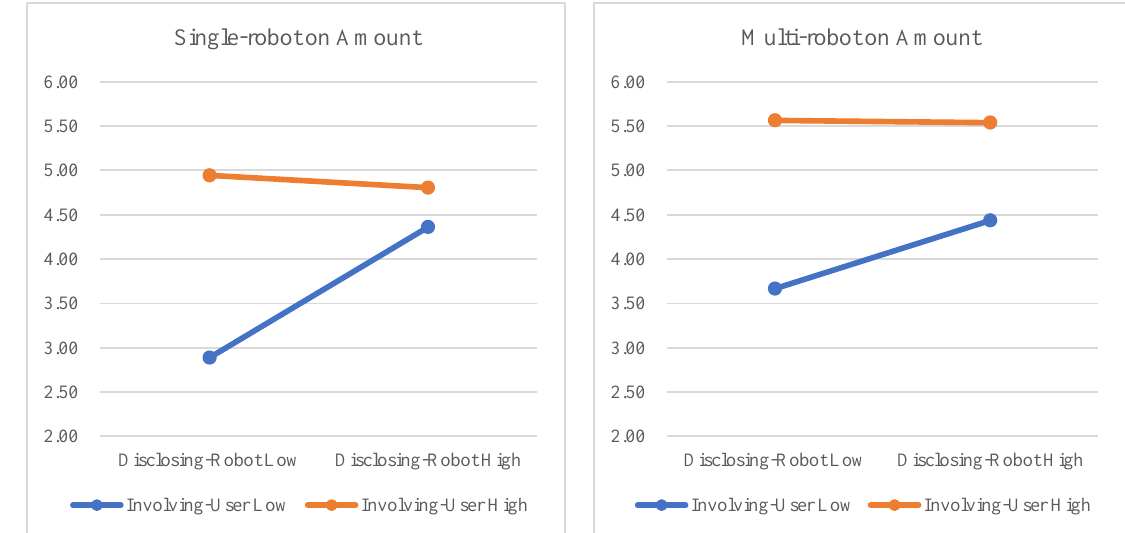
Figure 10. Moderation effects of multi-robot on amount.